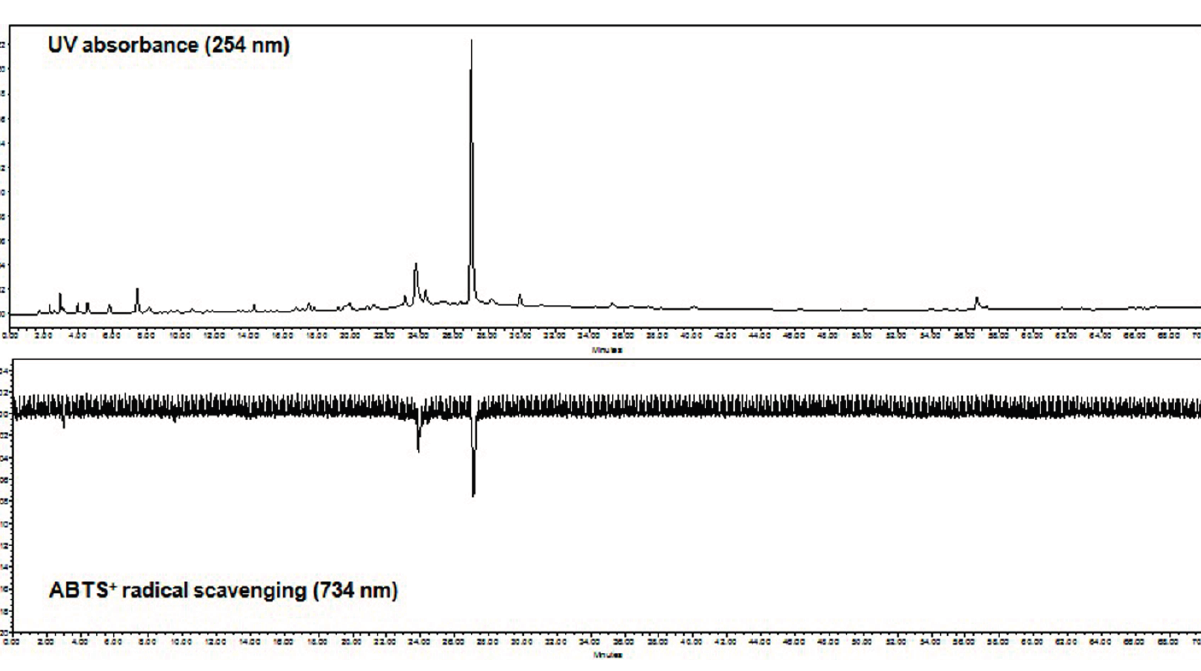
Figure 4. On-line HPLC-ABTS +• radical quenching 2D chromatograms of E. hirta crude ethanol extract. A 10 μ L of E. hirta extract was analyzed by gradient